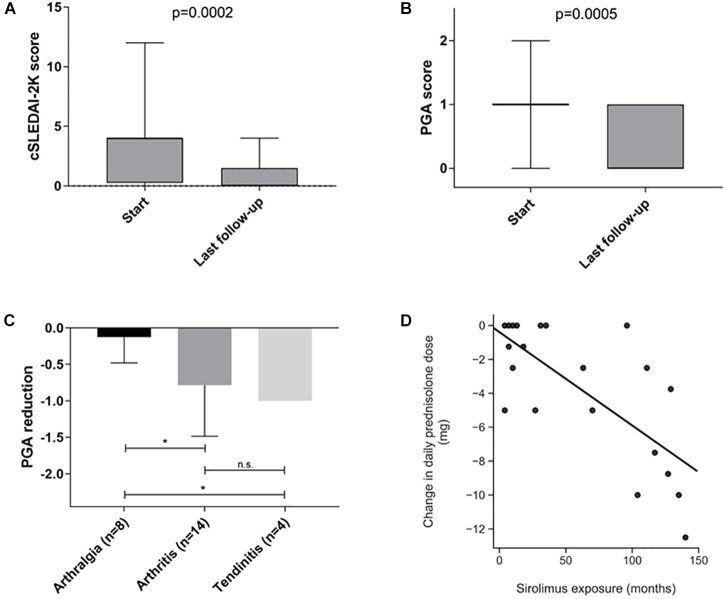
(A–D) Differences in global disease activity between start/initiation of sirolimus therapy with regard to (A) clinical SLEDAI-2K, and (B) physician’s global assessment (PGA). (C) Illustrates the reduction of PGA scores with regard to type of musculoskeletal manifestation. (D) Demonstrates the correlation between reduction of daily corticosteroid dose and the exposure of sirolimus in months. ∗p < 0.05.